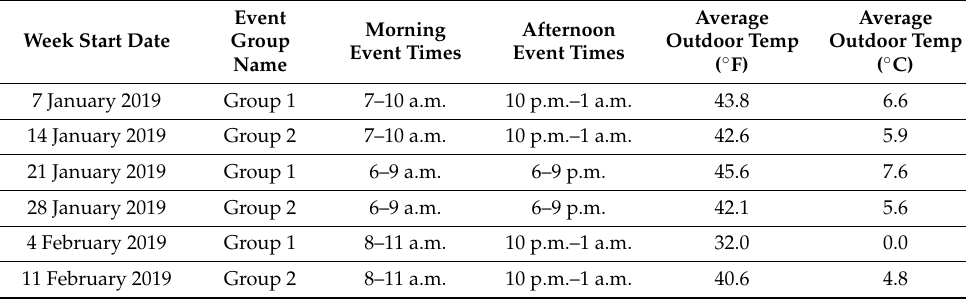
Table 2. Non-targeted Strategy